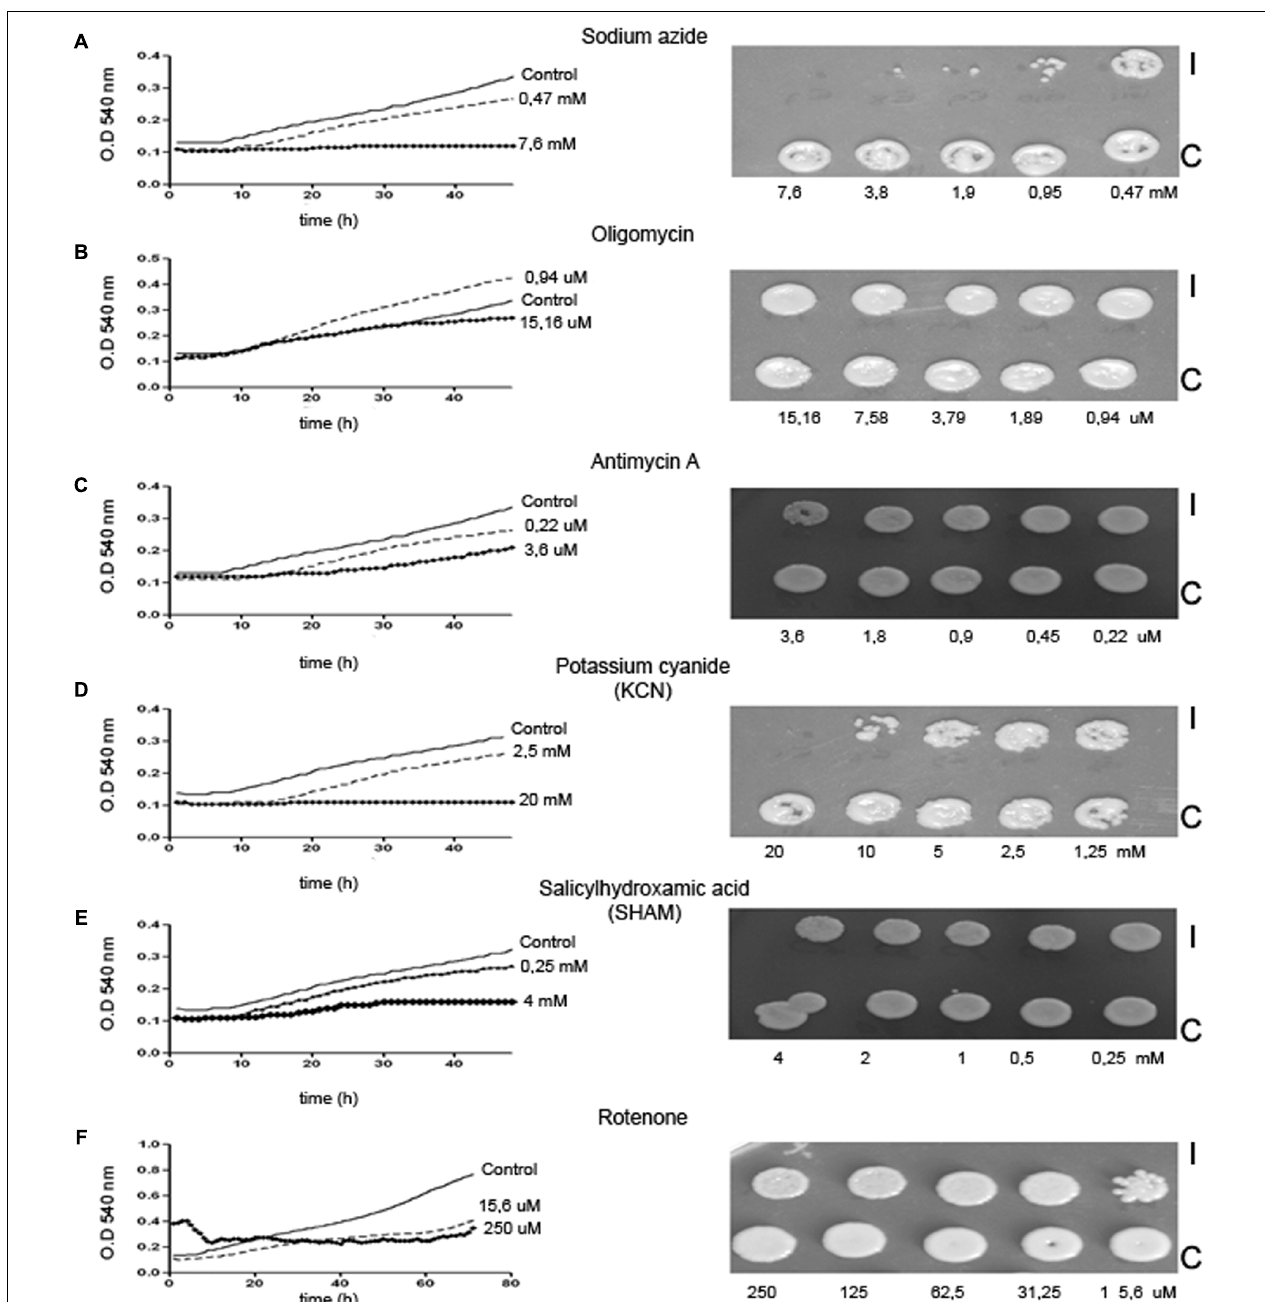
FIGURE 2 | Effect of mitochondrial inhibitors on Cryptococcus neoformans . C. neoformans cells were cultured in liquid Sabouraud in presence of different metabolic inhibitors [sodium azide (A) , oligomycin (B) , antimycin A (C) , potassium cyanide (D) , salicylhydroxamic acid (E) , and rotenone (F) ] in 96-well plates and growth curves were performed at 48 or 72 h at 30 ◦ C. After this incubation time, 10 µ L from the wells incubated with the inhibitor (I) or control carrying only the same concentration of solvent (C) were placed on Sabouraud agar plates and incubated at 30 ◦ C during 48 h. After that time, photographs were taken (right